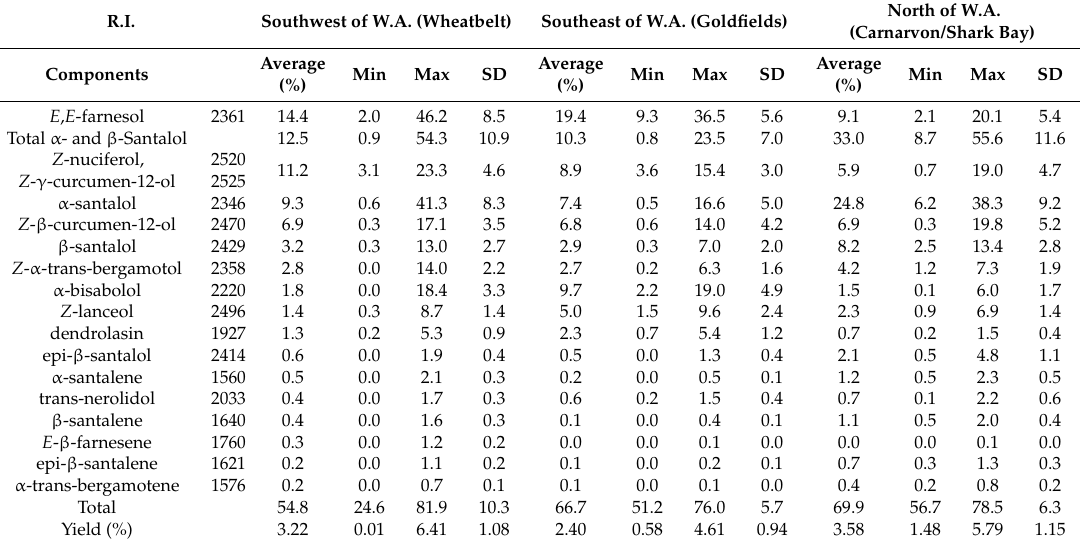
Table 1. Sesquiterpene composition of S. spicatum heartwood oil extracts from three different regions of West Australia (Wheatbelt, Goldfields and